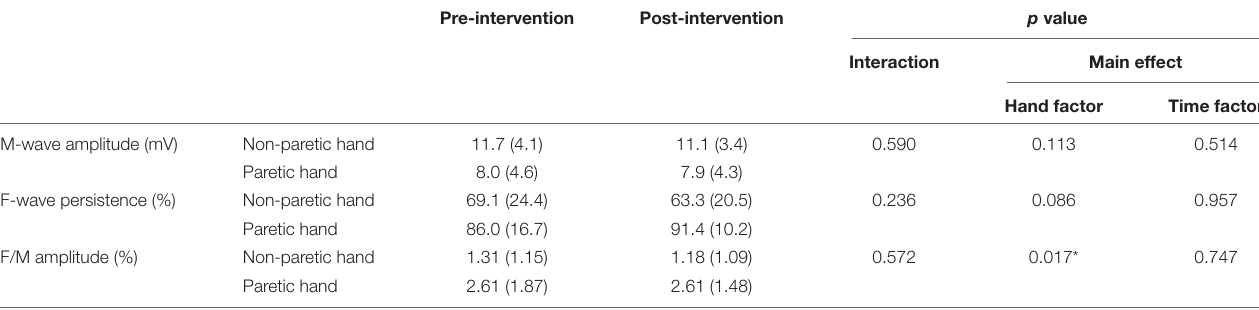
TABLE 3 | Results of M-wave, F-wave persistence and F/M